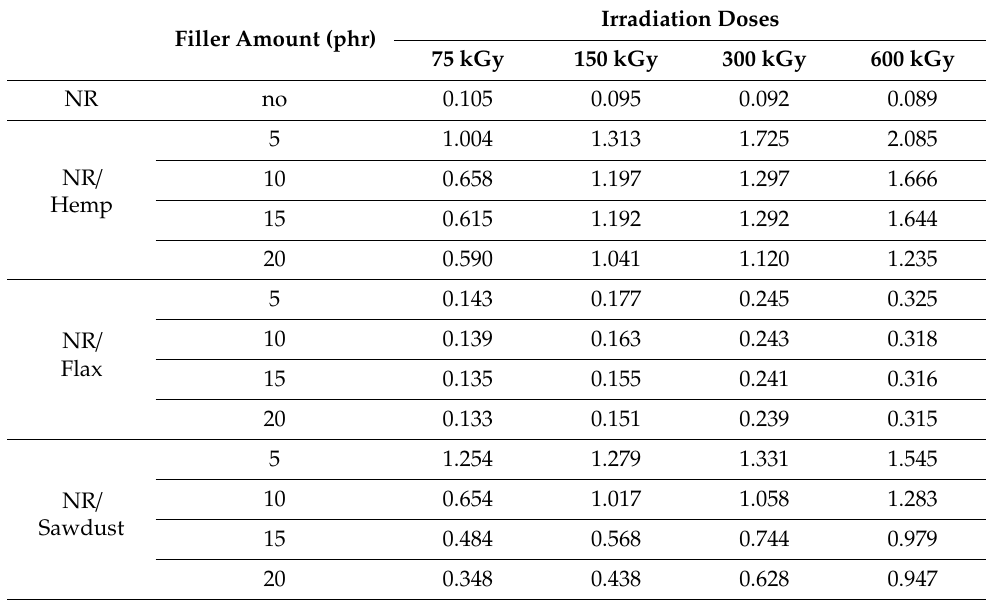
Table 4. Q eq. (mol%) variation for NR, NR / hemp, NR / flax, and NR / sawdust samples Filler Amount